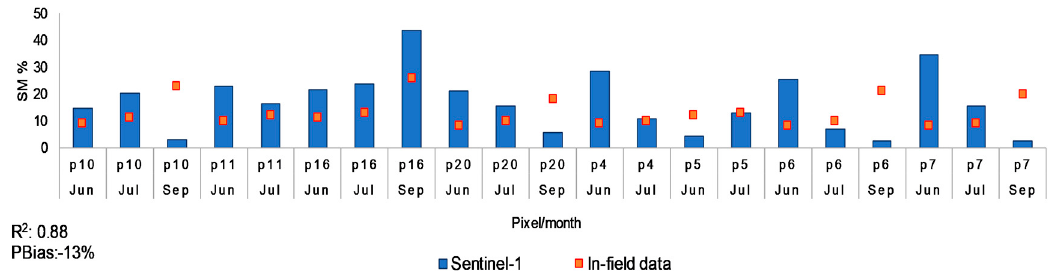
Figure 2. Comparison of volumetric soil moisture (SM) between Sentinel-1 retrievals and in-field measurements in PGNP for three dates where Sentinel-1 passed the region during the summer of 2016 (7th of June, 12th of July, and 21st of September).